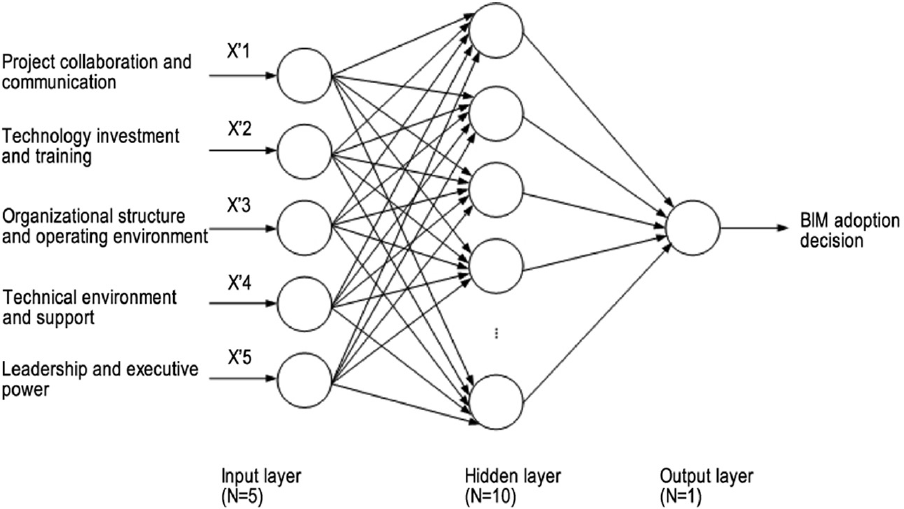
Fig. 3. Network architecture of